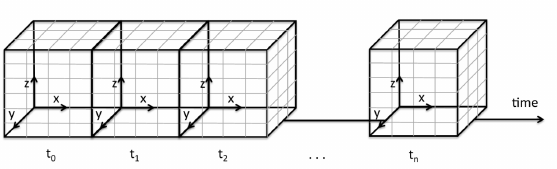
Figure 8. 4D-Grid coding of the airspace. 4D-Grid coding of the airspace. This structure strongly speeds up the neighborhood search for a given